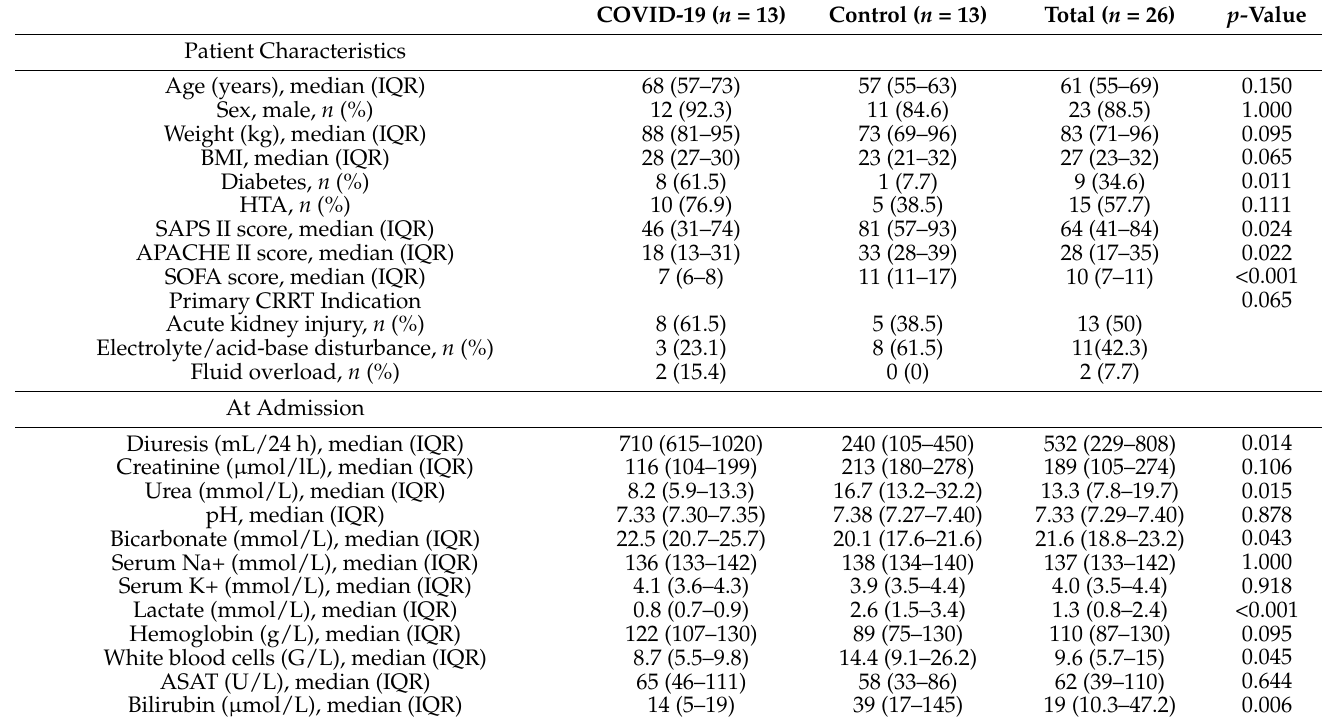
Table 1. Characteristics of included